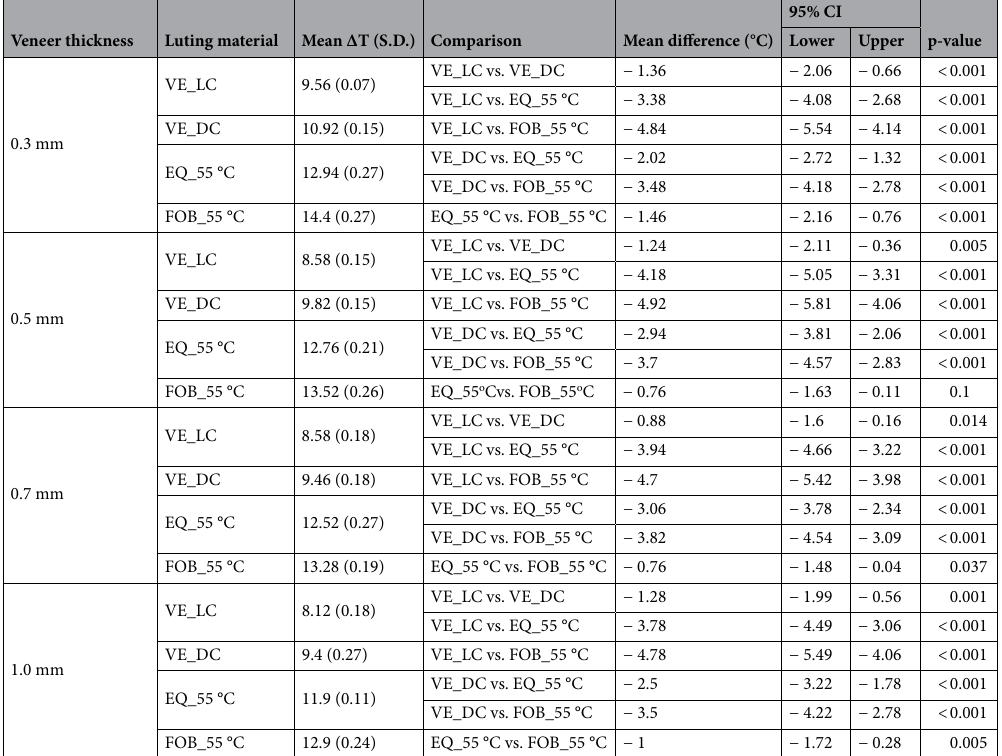
Table 2. Comparison of intrapulpal temperature change during polymerization of ceramic veneers with different luting materials. One-way analysis of variance (ANOVA) and Tukey’s post hoc adjustment. VE_LC Variolink Esthetic LC, VE_DC Variolink Esthetic DC, EQ_55 °C pre-heated Estelite Sigma Quick, FOB_55 °C pre-heated Filtek one bulk restorative, LC light-cure, DC dual-cure, S.D. standard deviation, CI confidence